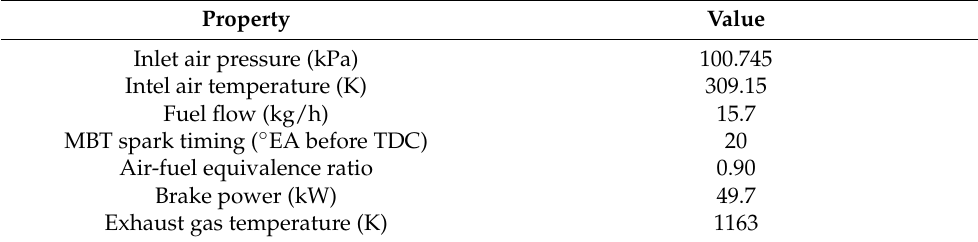
Table 2. Test data for Wankel engine operating at 7550 RPM and WOT